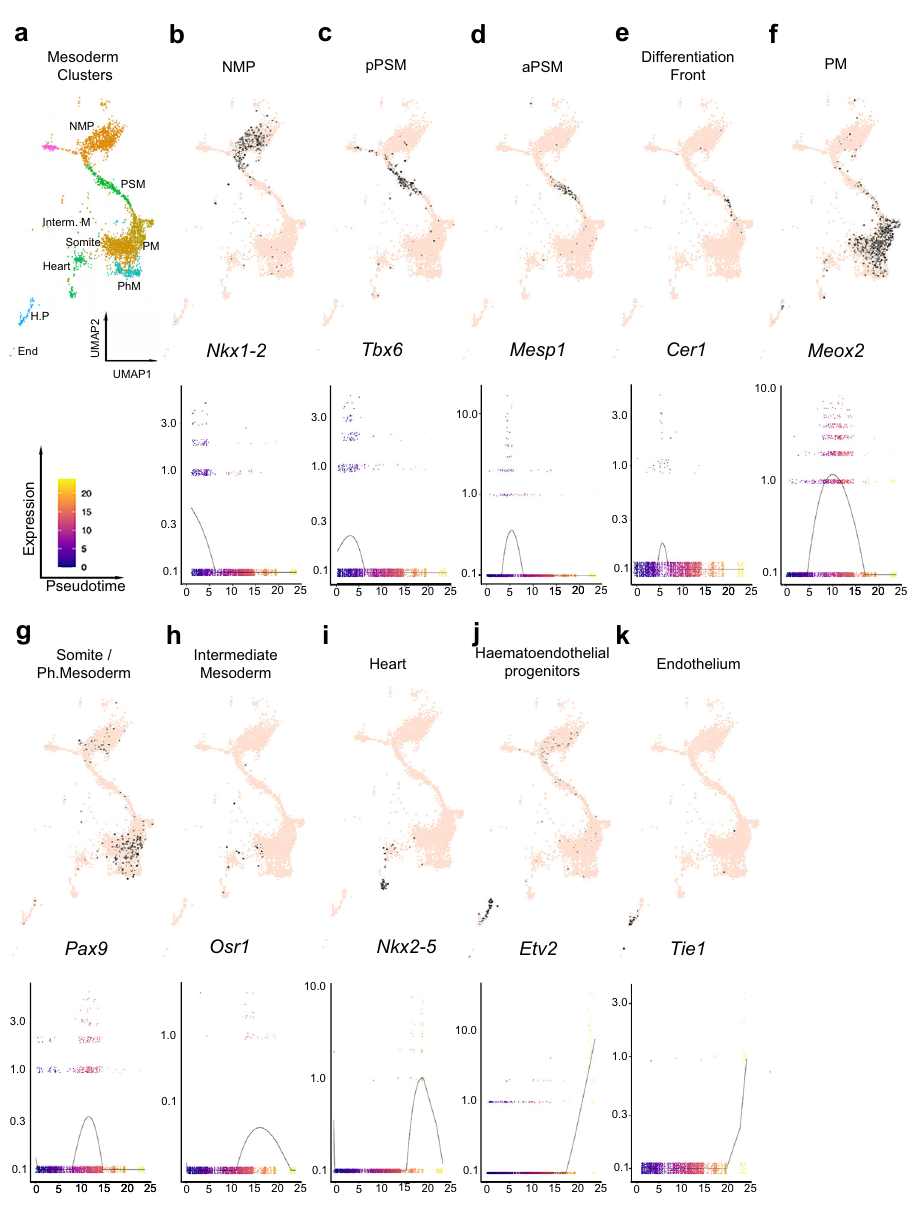
Fig. 9 Mesoderm clusters, subclusters and mesodermal pseudotime differentiation of their speci fi c marker genes. a Selected mesoderm clusters: NMP: neuromesodermal progenitors, PSM: presomitic mesoderm, PM: paraxial mesoderm, Interm. Mesoderm: intermediate mesoderm, somites, PhM: pharyngeal mesoderm, heart, hematopoietic prog. (progenitors), endothelium. b – k UMAP plot (top) and spline plot (bottom) representing changes of expression over pseudotime for marker genes of each cluster and subcluster: b Nkx1-2 for NMP, c Tbx6 for posterior presomitic mesoderm (pPSM), d Mesp1 for anterior PSM (aPSM), e Cer1 for the differentiation front, f Meox2 for PM, g Pax9 for somite and pharyngeal mesoderm, h Osr1 for intermediate mesoderm, i Nkx2-5 for heart, j Etv2 for haematoendothelial progenitors, k Tie1 for